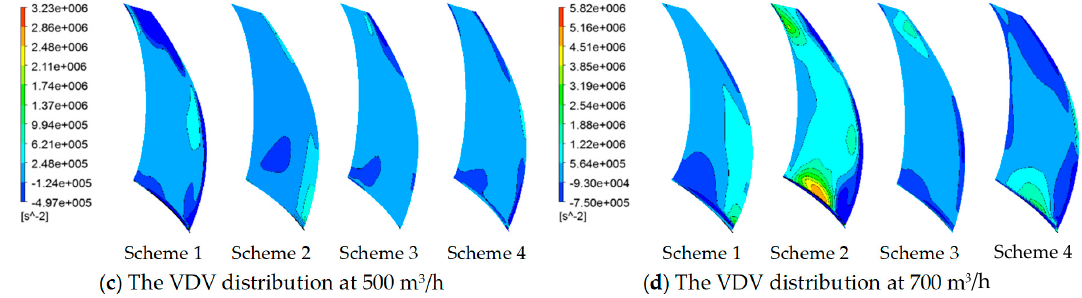
Figure 11. The VDV distribution at various flow conditions.